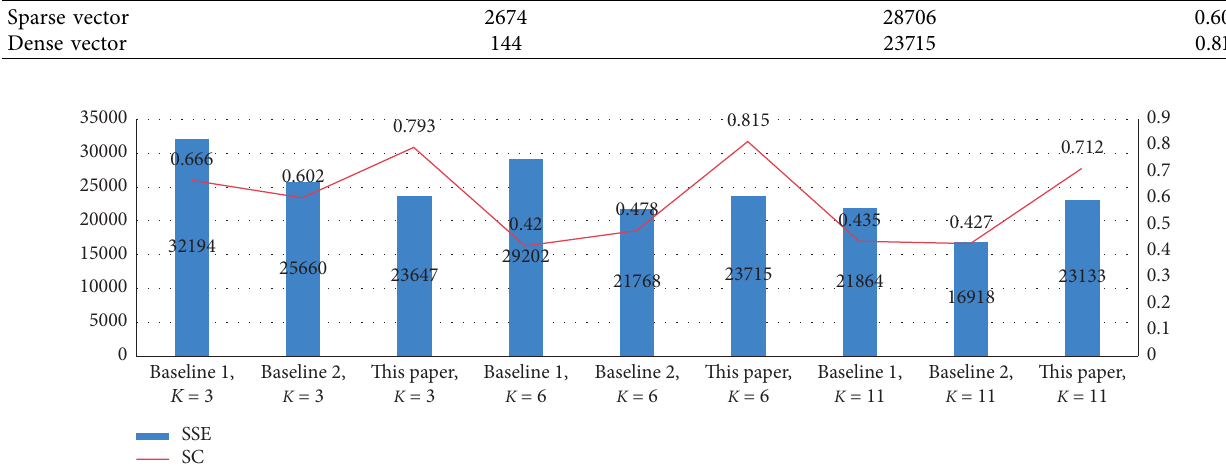
Figure 11: Comparison of